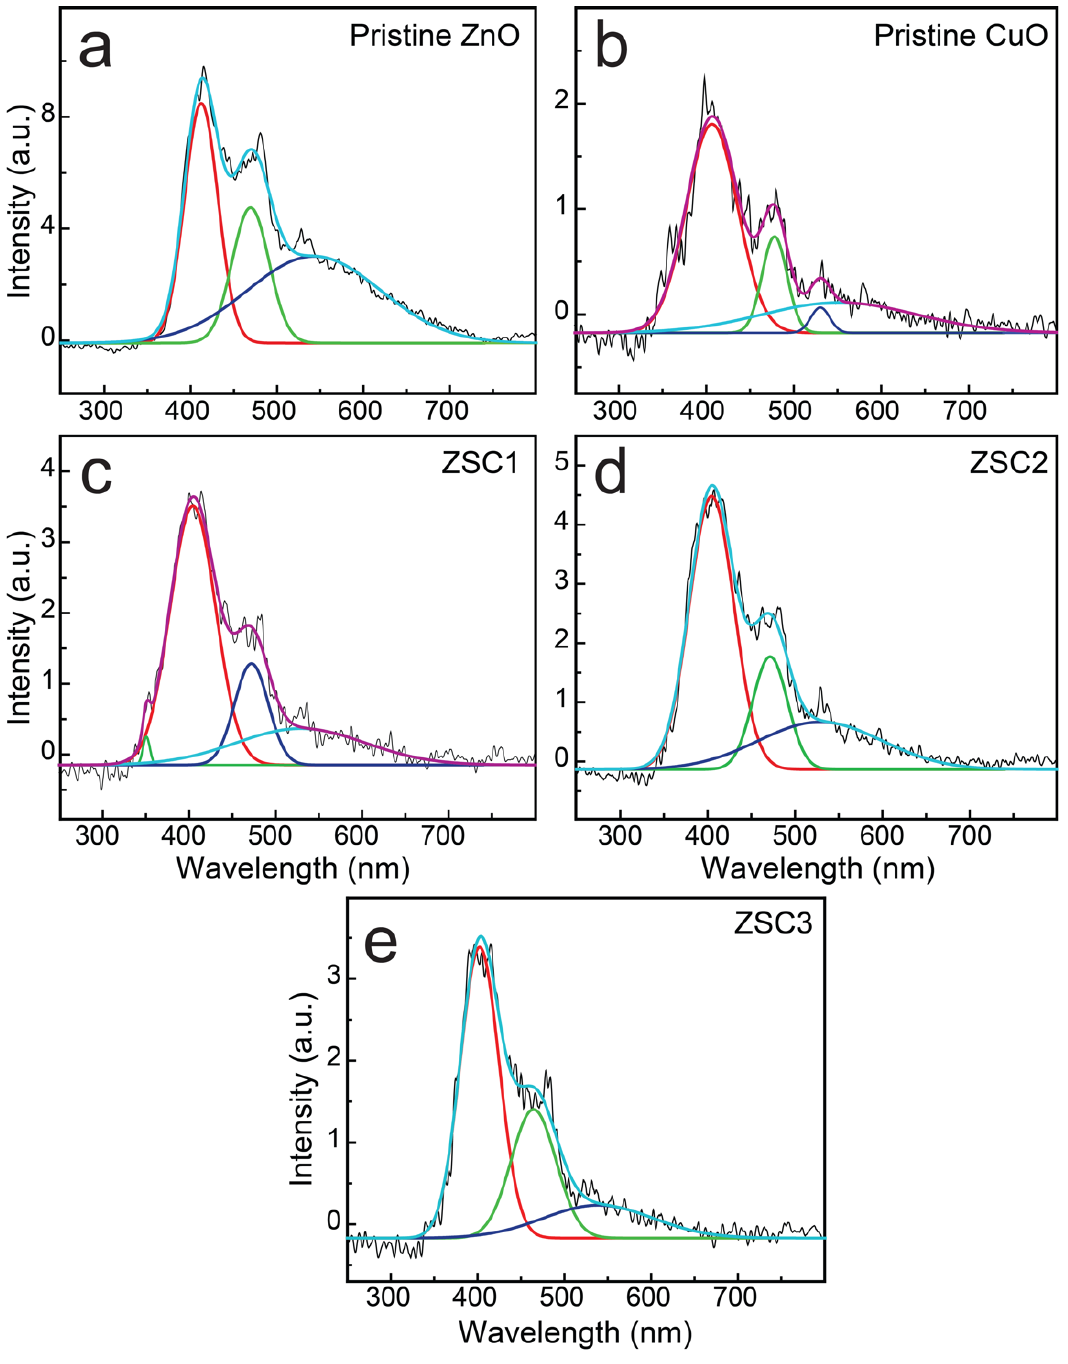
Figure 6. PL spectra for ( a ) pristine ZnO, ( b ) pristine CuO, ( c ) ZSC1, ( d ) ZSC2, and ( e ) ZSC3. Each spectrum is deconvoluted and the deconvoluted spectra are displayed together with each original spectrum.